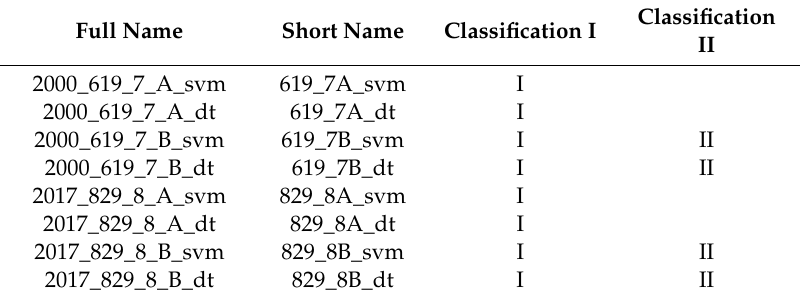
Distribution of di ff erent image processing methods of 2000 and 2017 images with di ff erent